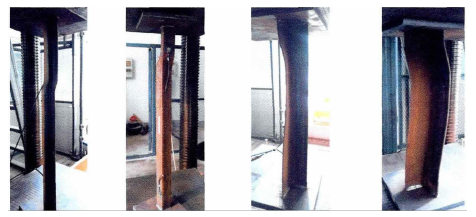
Fig. 4. Critical stresses of the struts. λ s and λ p is the slenderness ratios of a bar when its compression stress reaches the strength limit and the proportional limit of material.